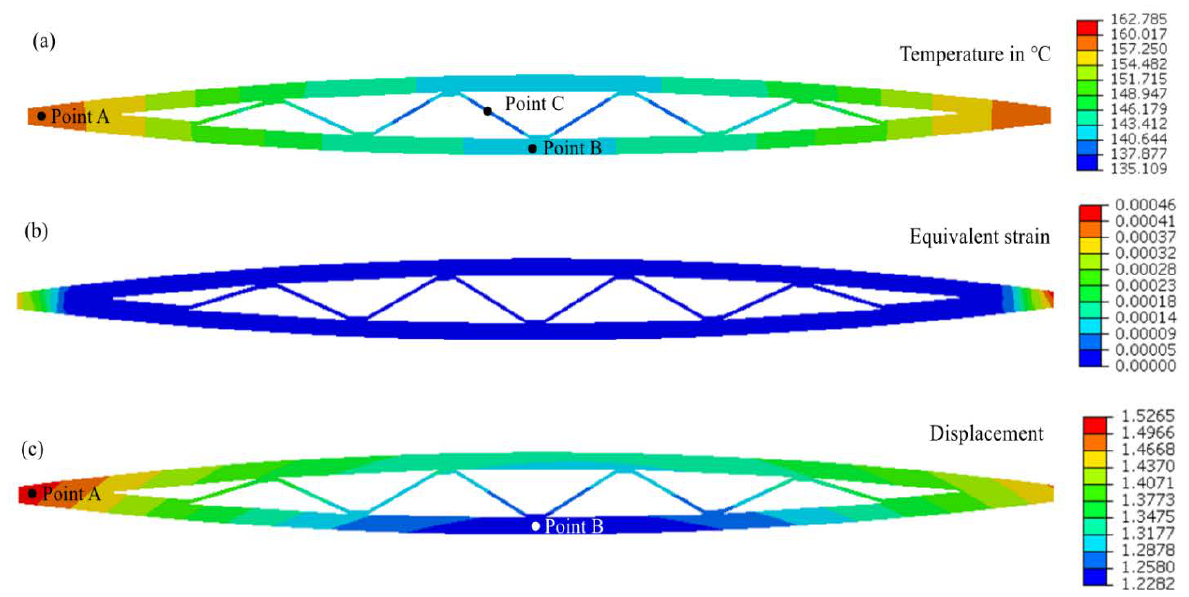
Figure 14. The results of an FEM analysis for the air cooling process with respect to: ( a ) temperature; ( b ) equivalent strain; ( c ) displacement.